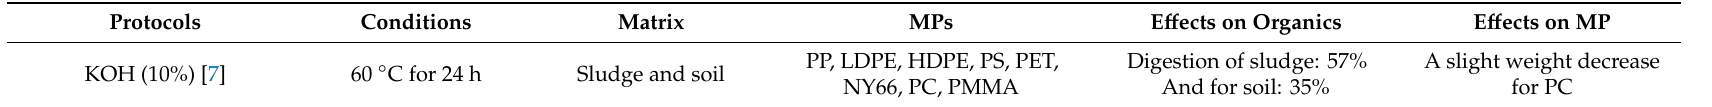
Table A4. Summary of various alkaline-based digestions used in microplastic studies. RT—Room